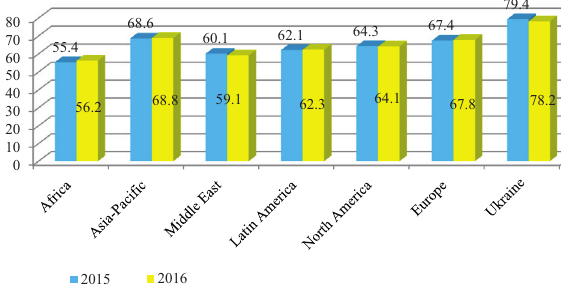
Figure 10. Load factor in international passenger traffic in Ukraine and other regions of the world